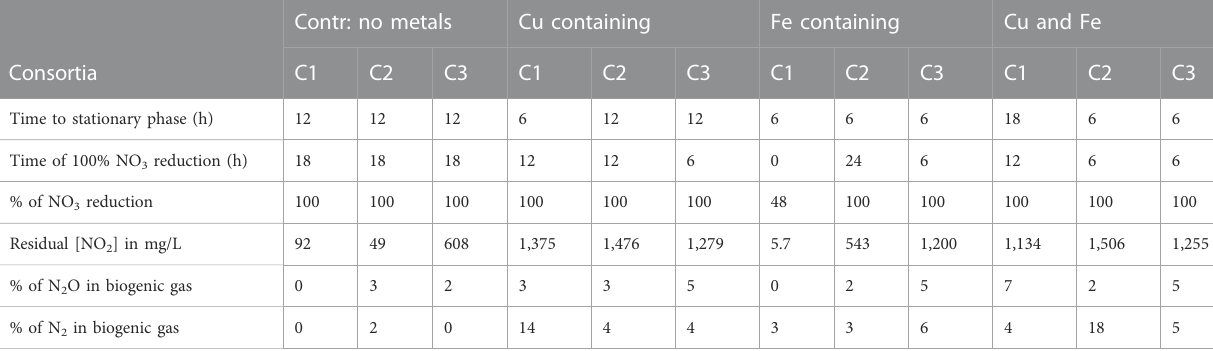
TABLE 2 Summary of the biogeochemical effects of metals (Cu and Fe) on denitri fi cation dynamics on the three selected consortia. Contr: no metals Cu containing Fe